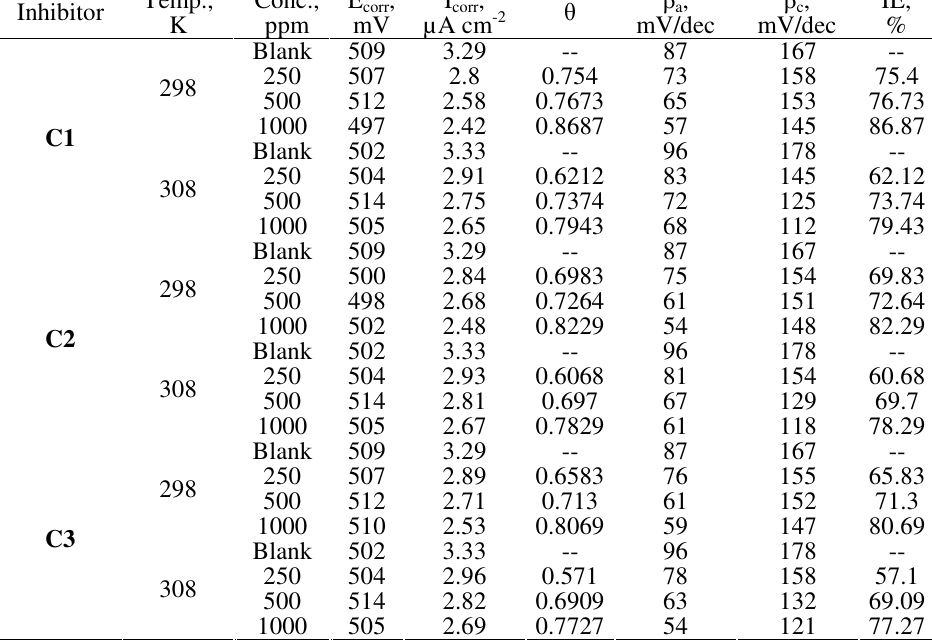
Figure 2. Galvanostatic polarization curve for different concentrations of inhibitors in 0.5 N HCl at 298 K. Table 2. Corrosion parameters obtained from polarization measurements of various inhibitors taken at different concentrations and different temperatures in 0.5 N HCl. Inhibitor